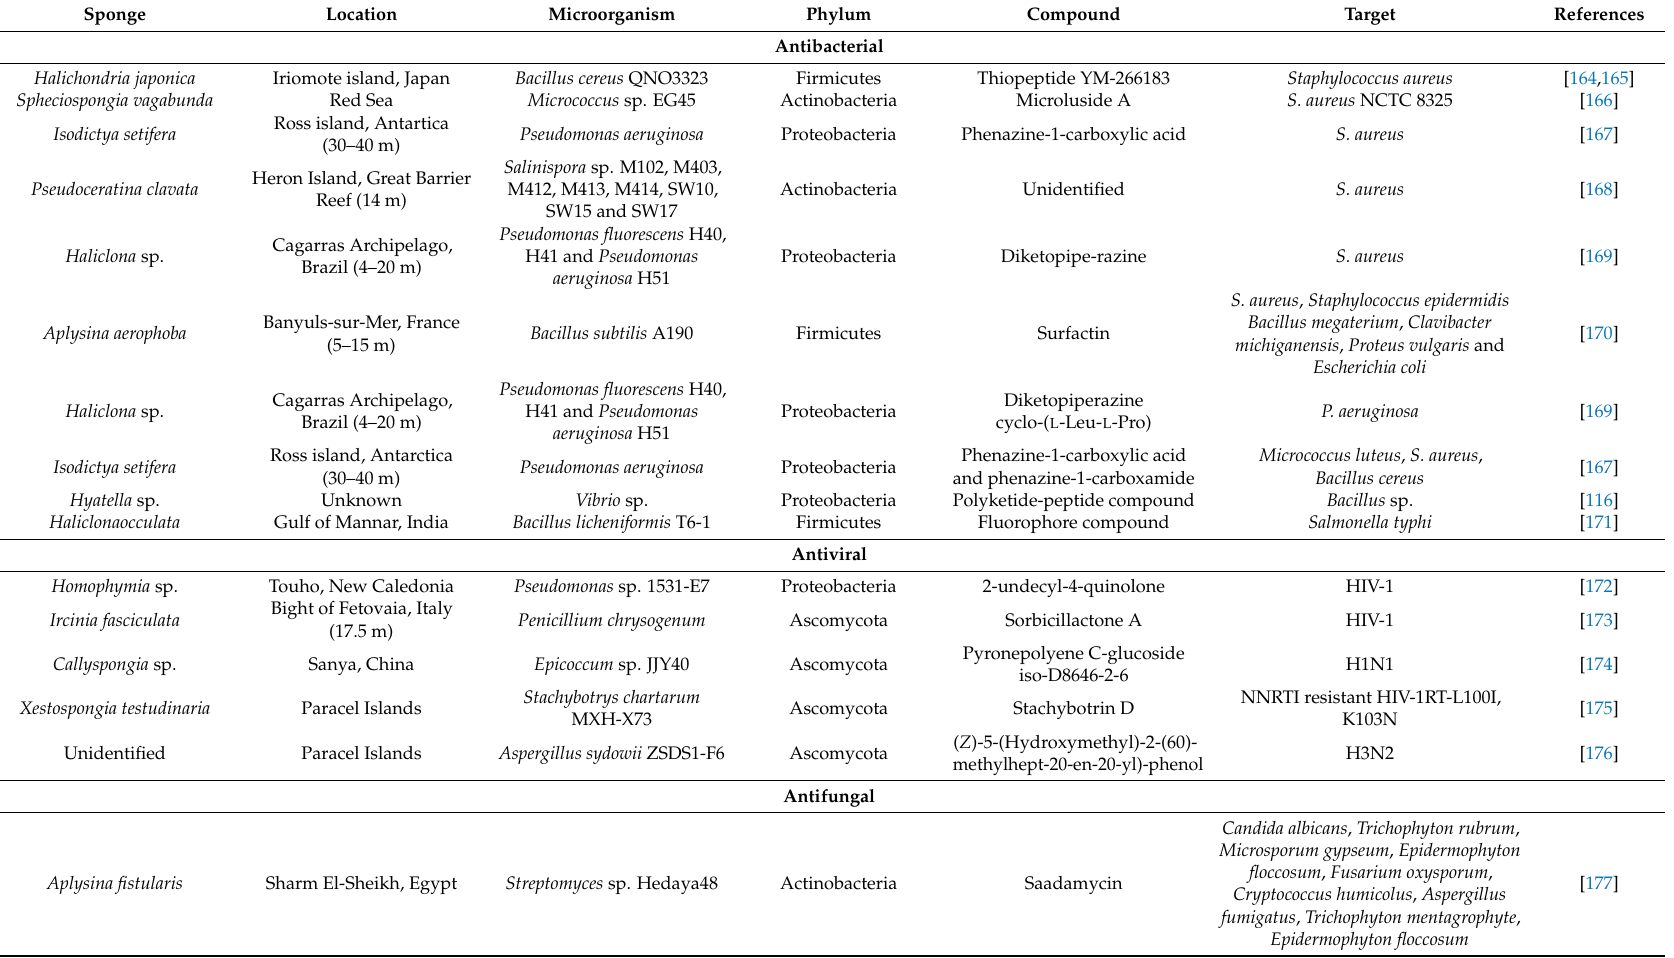
Table 2. Biologically active compounds with antibacterial, antiviral, antifungal, and antiprotozoal activity from sponge-associated microorganisms